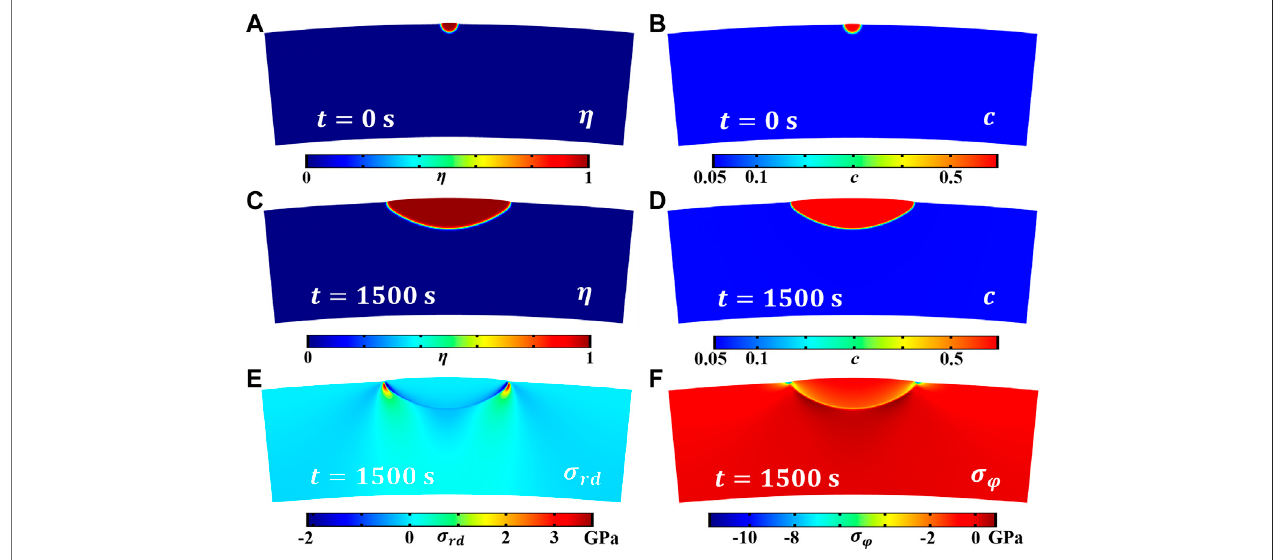
FIGURE 3 | The evolution results of the coupled anisotropic elastic energy zirconium hydride blister, where (A) and (C) are the morphology evolution results (order parameter fi eld) ofthe hydride blister growth at t = 0 sand t = 1,500 s, (B) ,and (D) is the distribution ofhydrogen concentration fi eld after t = 0 s and t =1,500 s, (E) and (F) are the stress distribution of σ rd (Radial stress) and σ φ (Circumferential stress).